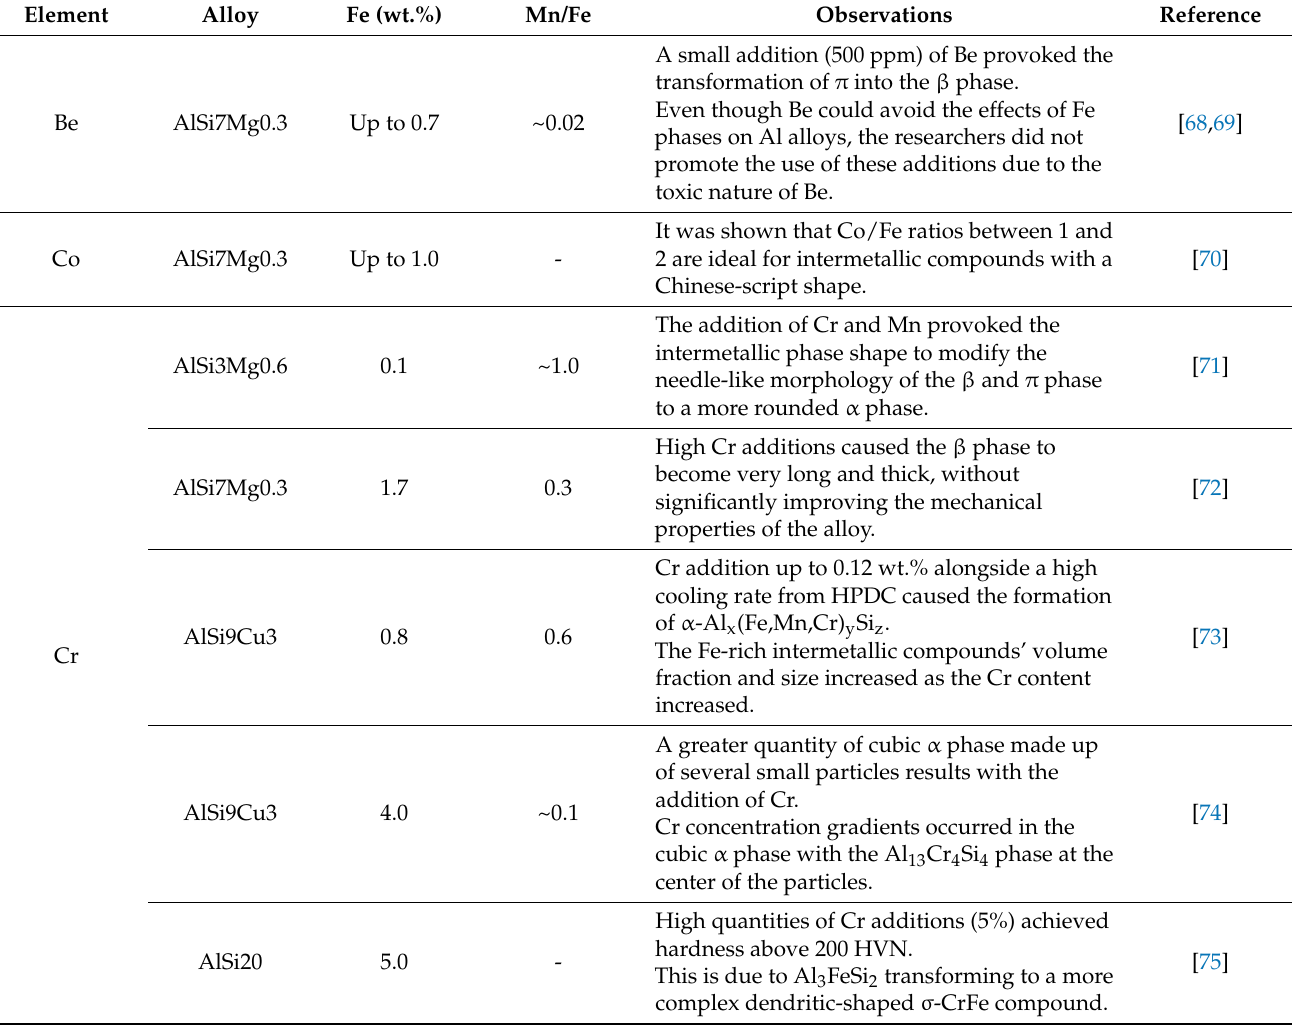
Table 4. An overview of elemental additions to SAAs in recent investigations processed by